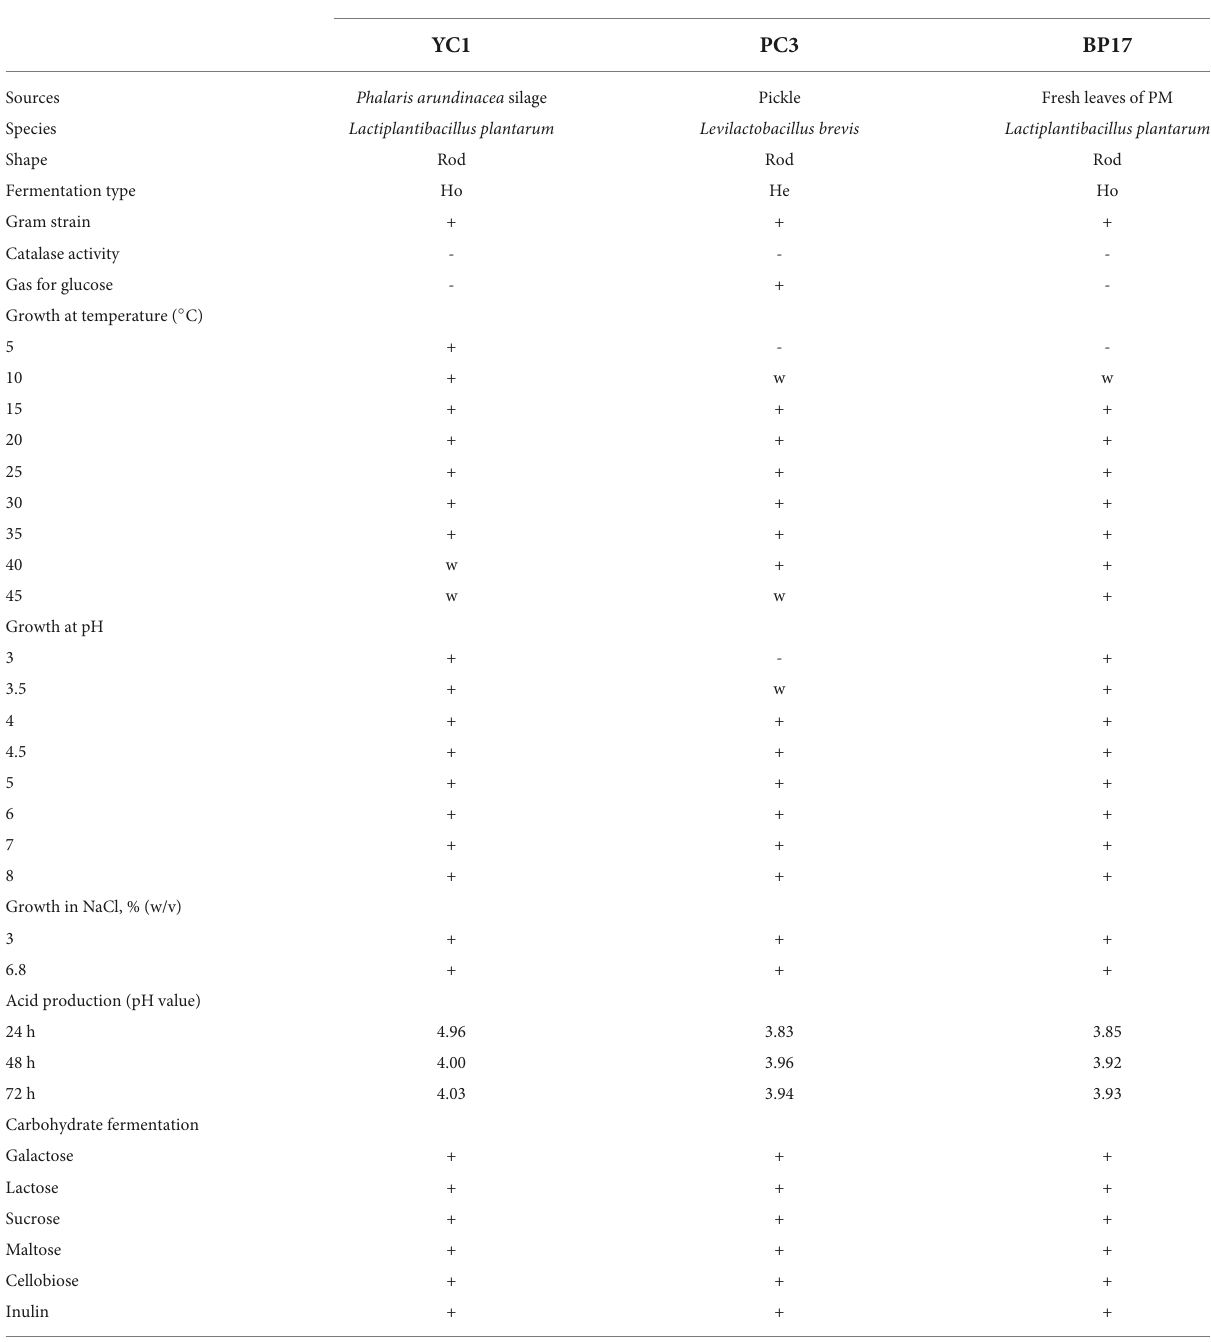
TABLE 1 Morphological, physiological, and biochemical properties of lactic acid bacteria isolates.